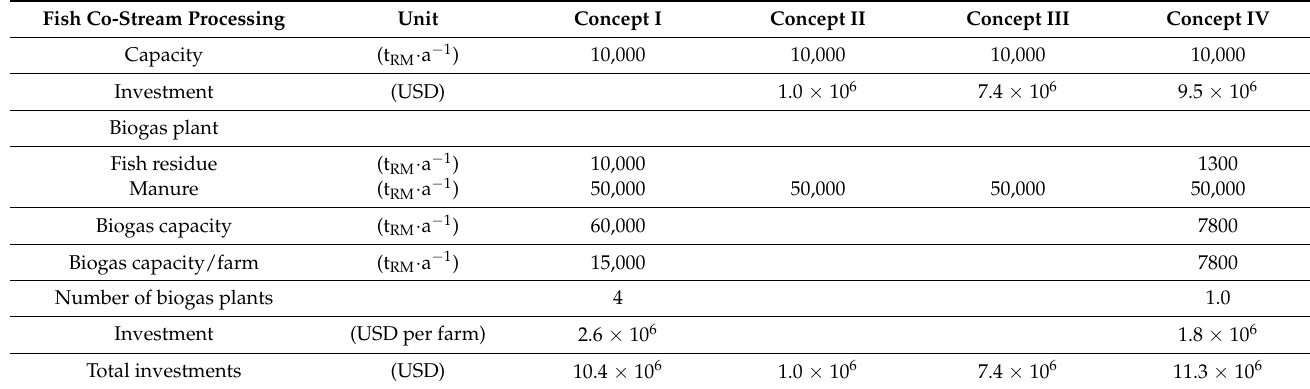
Table 5. Investment